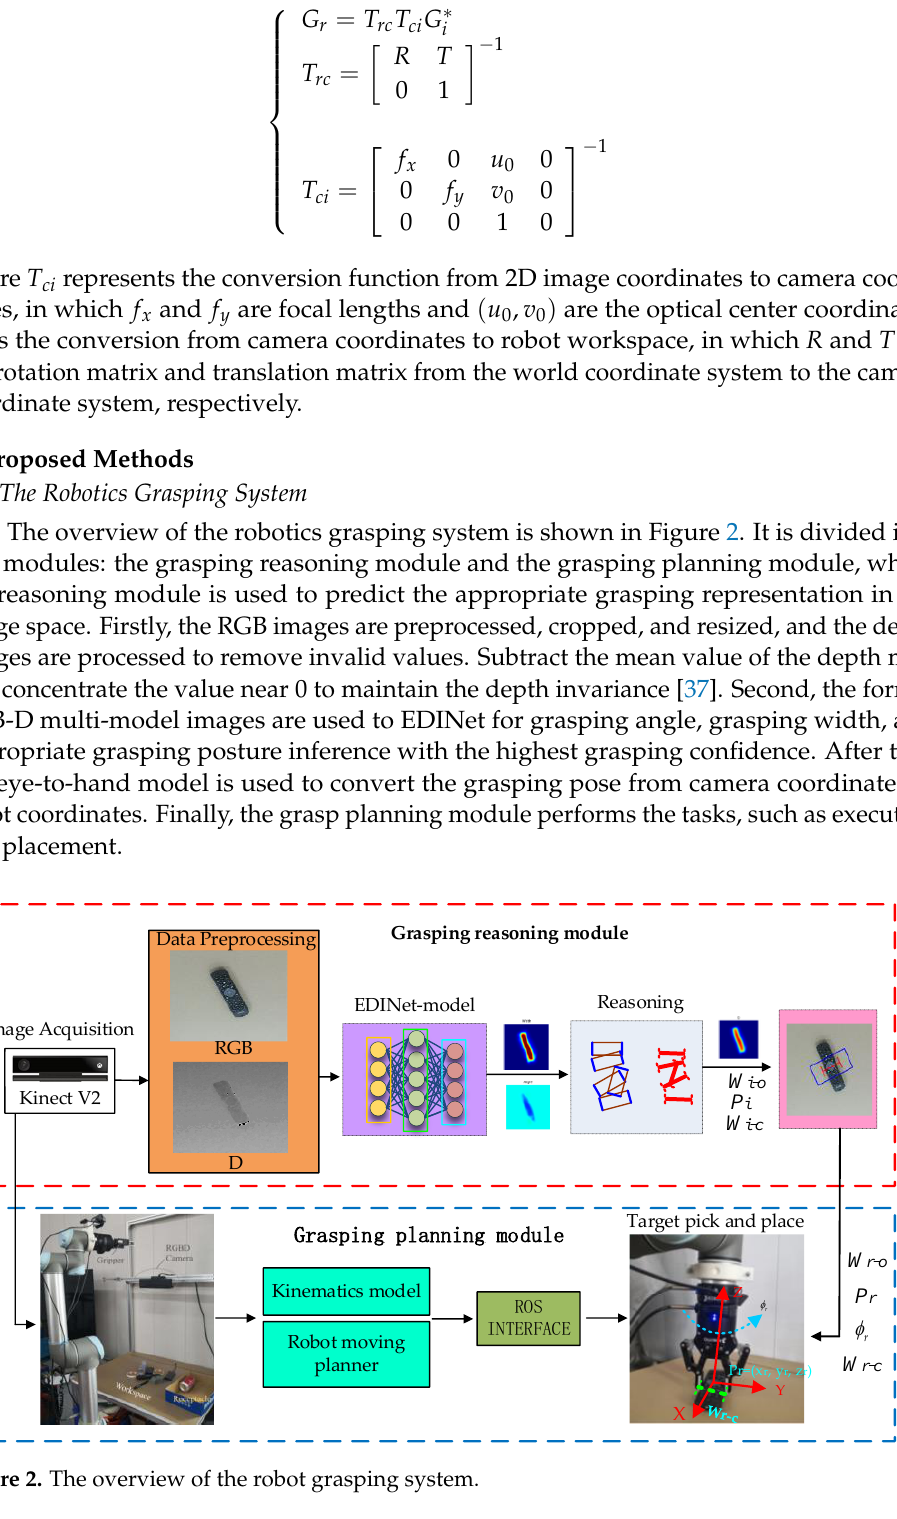
(d) Figure 3. The structure of EDINet: ( a ) encoder module, ( b ) decoder module, ( c ) inception module, ( d ) up-sampling module.